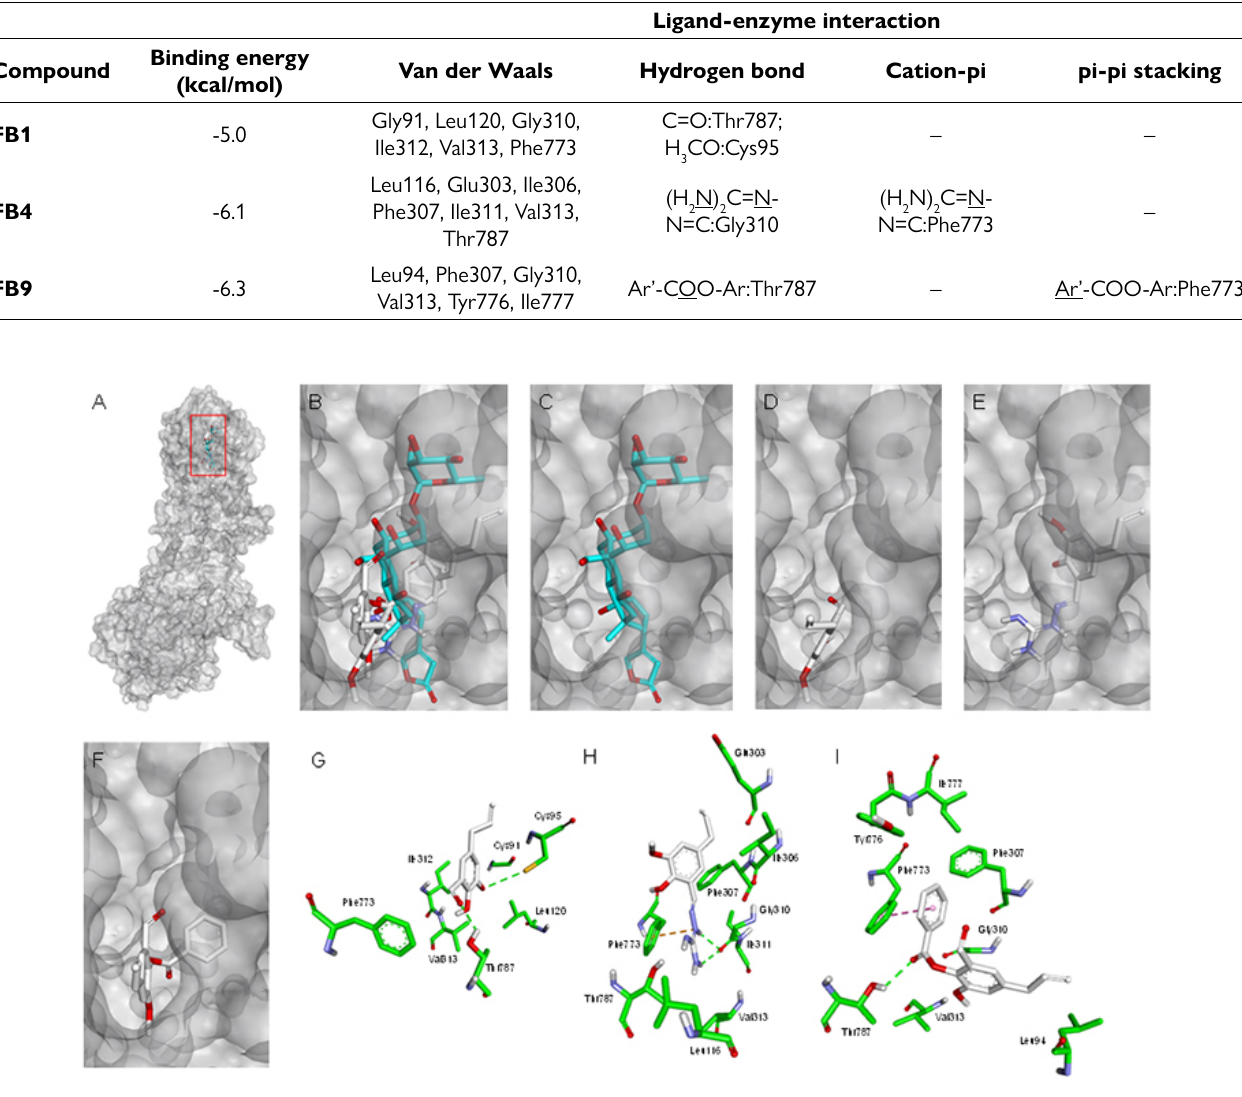
Figure 6. Docking poses and interactions of eugenol derivatives in the Schistosoma mansoni Na+/K+-ATPase alpha subunit. (A) Ligand interaction region, highlighted by the red square, in the S. mansoni Na+/K+-ATPase alpha subunit model (grey surface representation). (B) Relative position of docking poses of eugenol derivatives (white carbons). A modelled ouabain (cyan carbons) was included as reference. (C, D, E, F) Individual poses assumed by ouabain, FB1, FB4, and FB9, respectively, in the S. mansoni Na+/K+-ATPase alpha subunit model. (G, H, I) Interactions of FB1, FB4, and FB9 (white carbons), respectively, in the ouabain active site of the S. mansoni Na+/K+-ATPase alpha subunit (green carbons). Cation-pi interaction (dotted yellow line), hydrogen bonds (dotted green lines) and pi-pi stacking interactions (dotted pink line) are